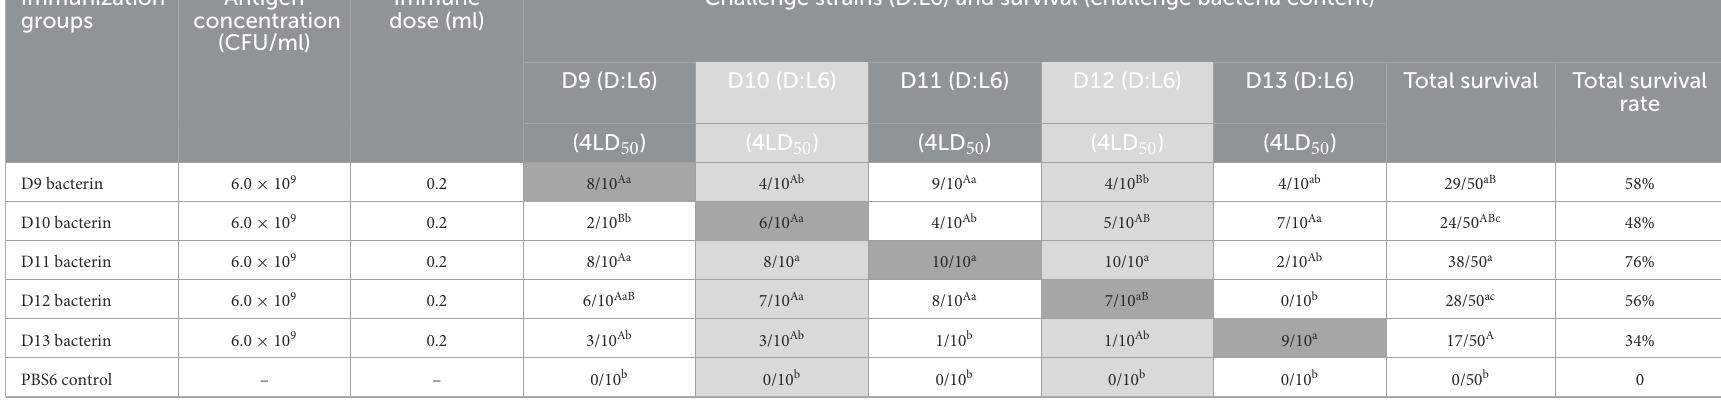
TABLE 7 Protection rate of D9–D13 bacterins against P. multocida strains